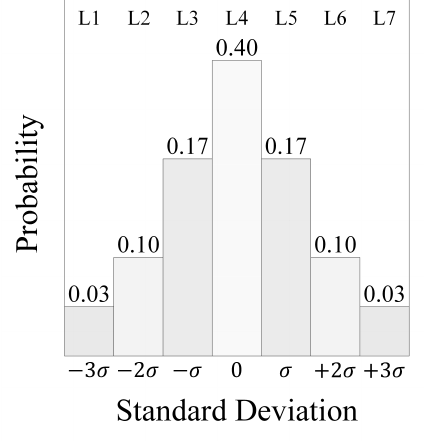
Figure 4. Stochasticity defined for wind and